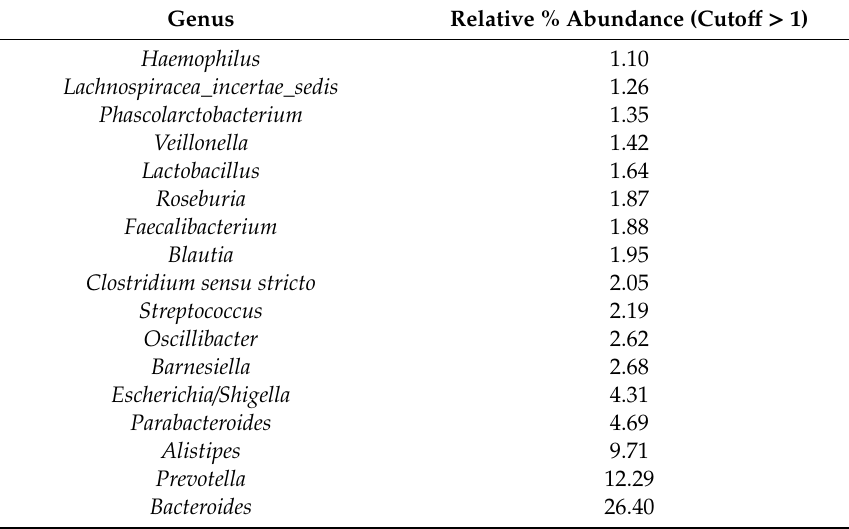
Table 4. Composition of the